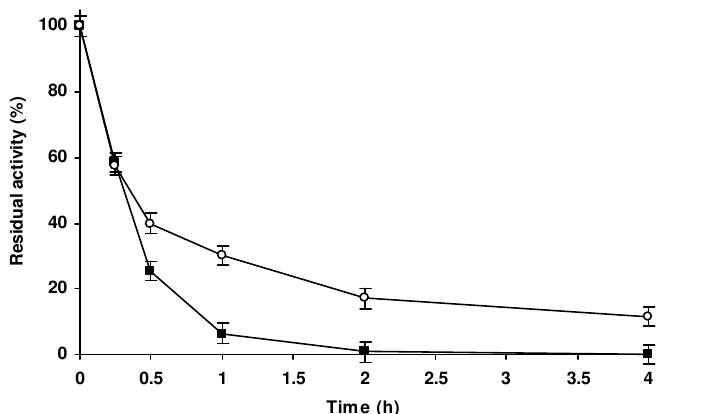
Figure 8. Thermal inactivation courses of soluble PGA in 50 mM of Tris HCl (solid squares) and Agarose-MANAE-VS-PGA immobilized at pH 7, incubated for 5 h at pH 10, and blocked with Gly (empty circles). Other details can be found in the Materials Section.